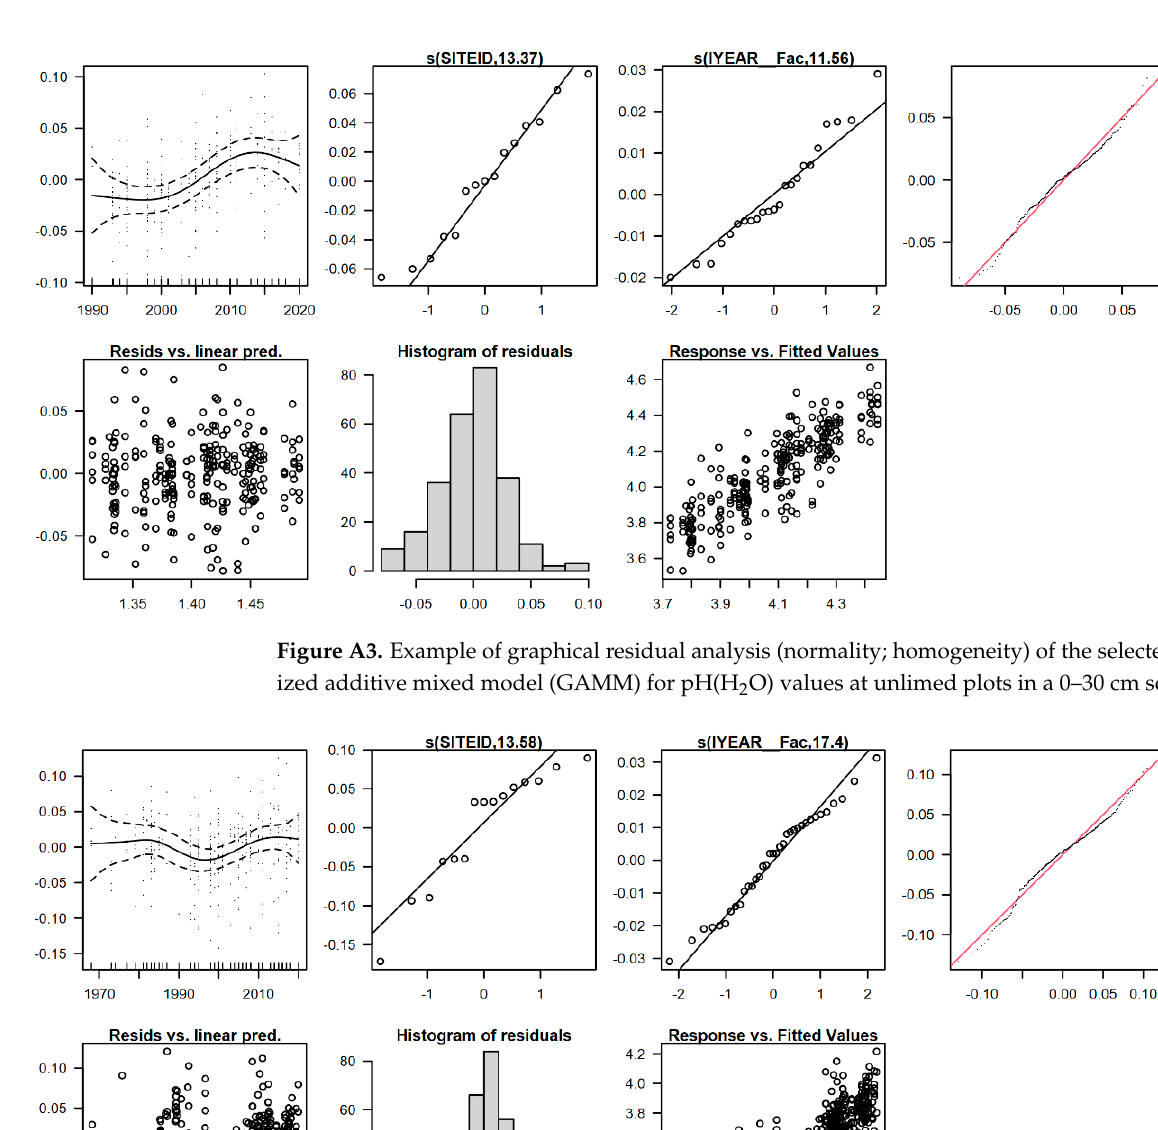
Figure A2. Example of graphical residual analysis (normality; homogeneity) of the selected gener- alized additive mixed model (GAMM) for the base saturation at unlimed plots in a 0–30 cm soil depth.